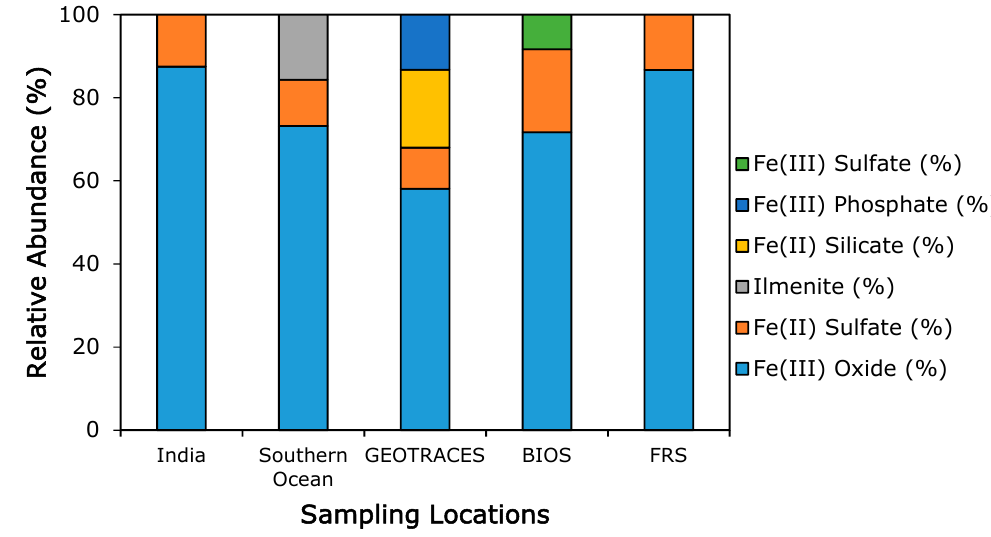
Figure 3. Average aerosol iron mineralogy for each sample set is shown. Fe(III) oxides and Fe(II) sulfates are prevalent in all sample sets. GEOTRACES and BIOS samples also contain Fe(II) silicates, Fe(III) sulfates, and Fe(III) phosphates.